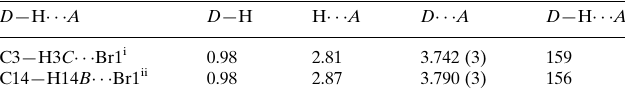
Hydrogen-bond geometry (A˚ , (cid:5)